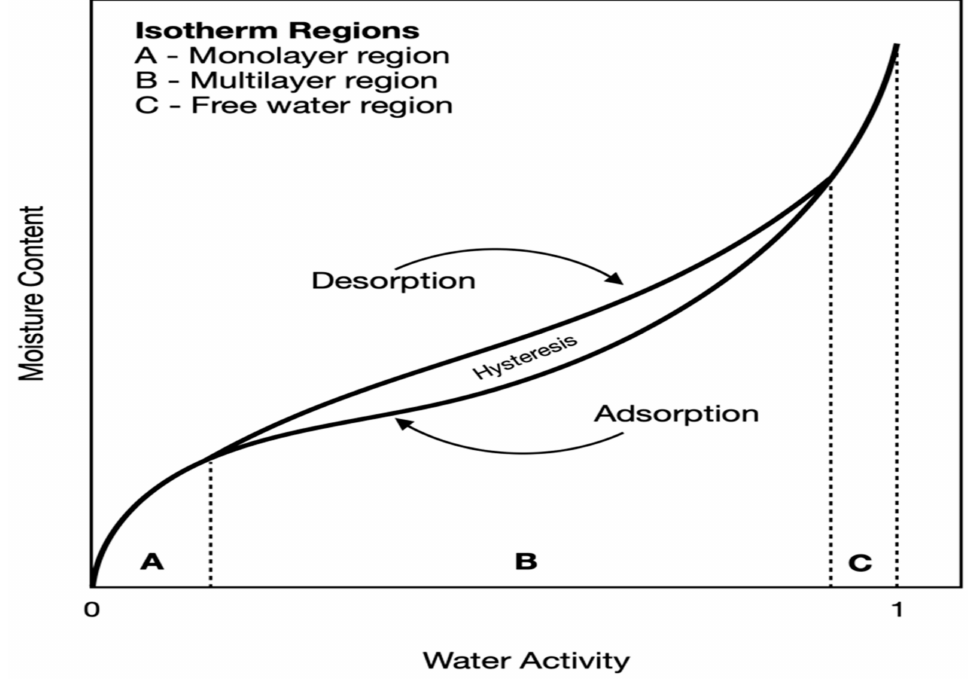
Figure 5. Sorption isotherms in biological materials (reproduced from